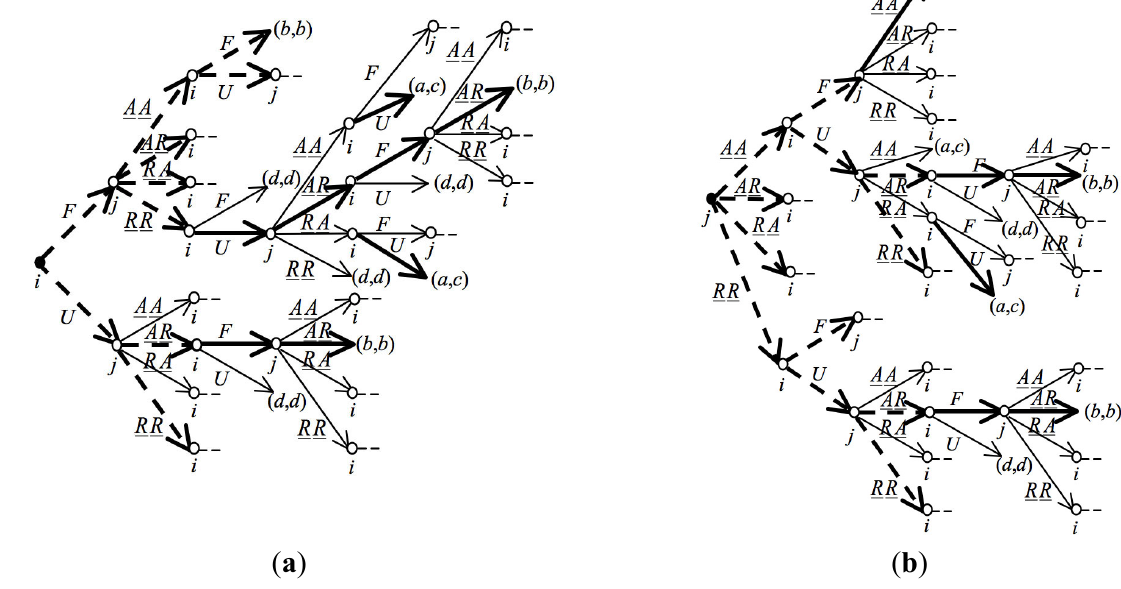
Figure 16. CP ( G ), G being the Ultimatum Minigame, with i ( a ) or j ( b ) as first